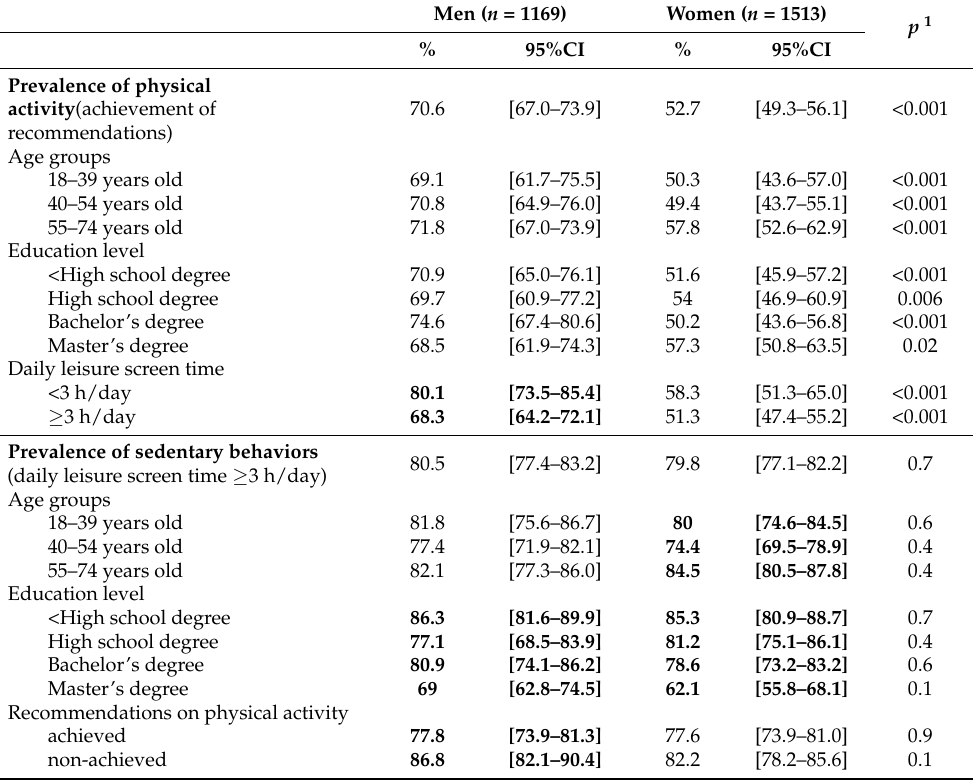
Table 2. Prevalence of physical activity and sedentary behaviors in adults (18–74 years old) in the Esteban study